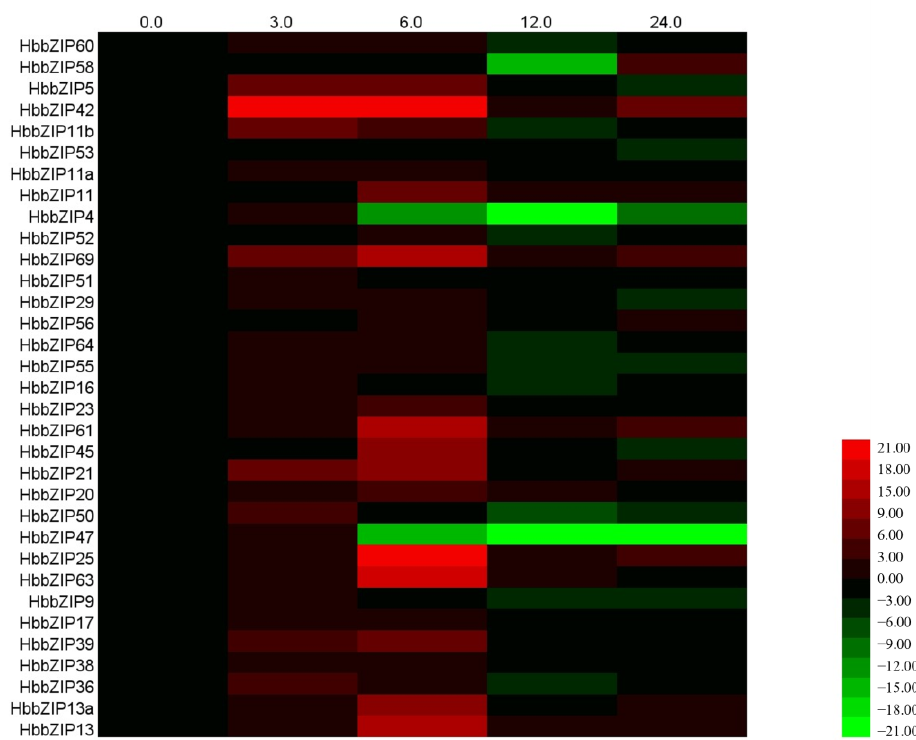
Figure 6. Expression of 33 HbbZIPs in rubber trees in response to powdery mildew infection.